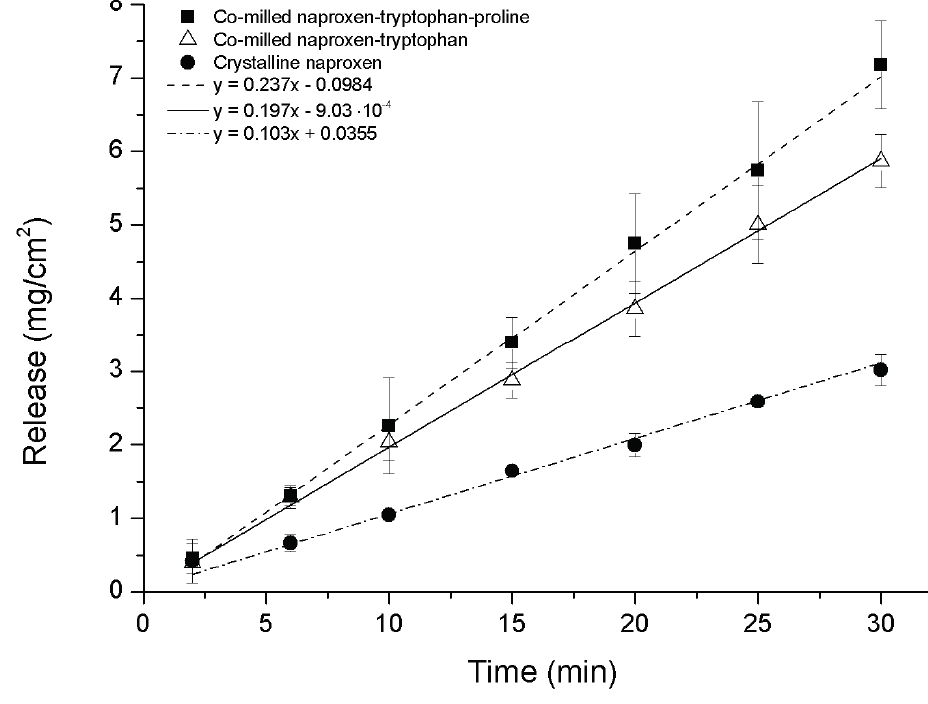
Figure 8. Intrinsic dissolution profiles of crystalline NAP, non-amorphous ball-milled NAP–TRP and co-amorphous NAP–TRP–PRO ( n = 3, mean ± standard